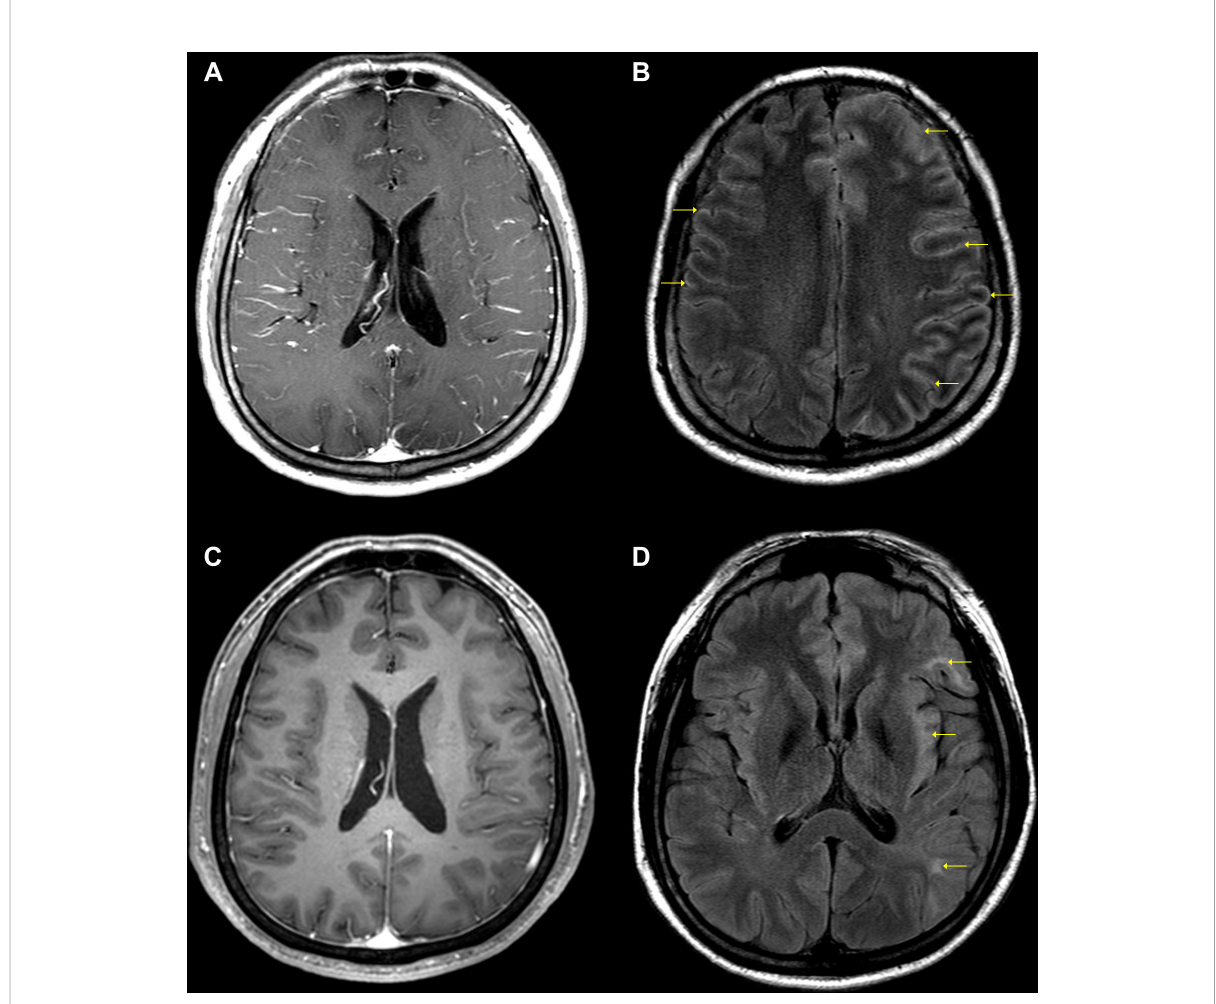
any parenchymal abnormalities on post-contrast T1WI. (B) Diffuse leptomeningeal enhancement predominantly in the left cerebral sulci (arrows) on contrast-enhanced FLAIR sequence. (C) Near-complete resolution of diffuse leptomeningeal enhancement on post-contrast T1WI. (D) Multiple cerebral lesions at the left insular cortex and subcortical white matter of the left frontal and temporal gyri (arrows) on FLAIR sequence. TIWI, T1-weighted imaging; FLAIR, fl uid-attenuated inversion